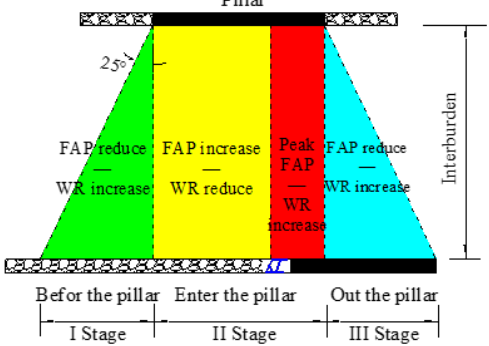
Figure 16. Evolution of FAP and WR by passing the coal